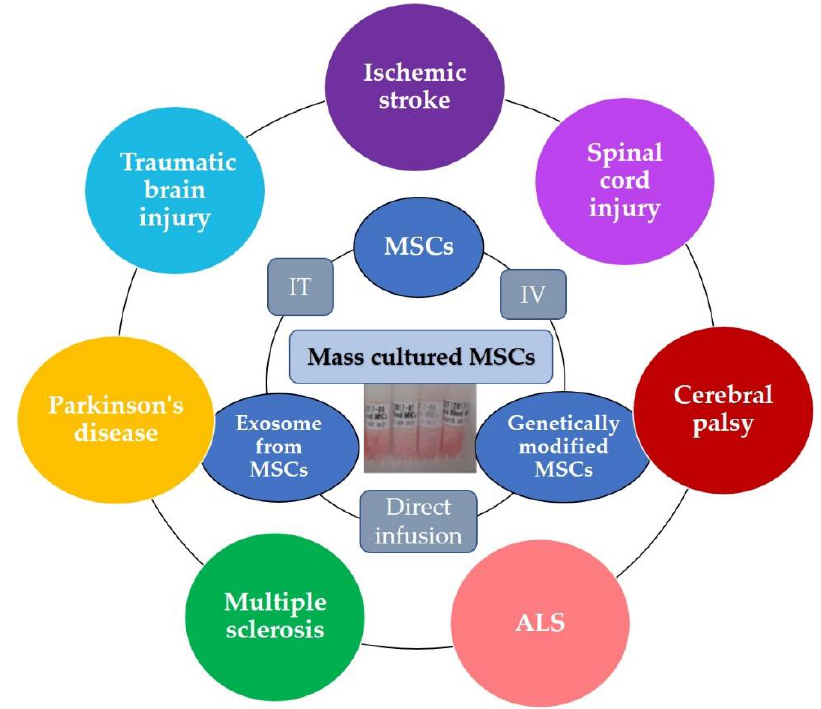
Figure 2. Therapeutic protocol of the clinical use of MSCs and exosomes for neurological disorders in the future.